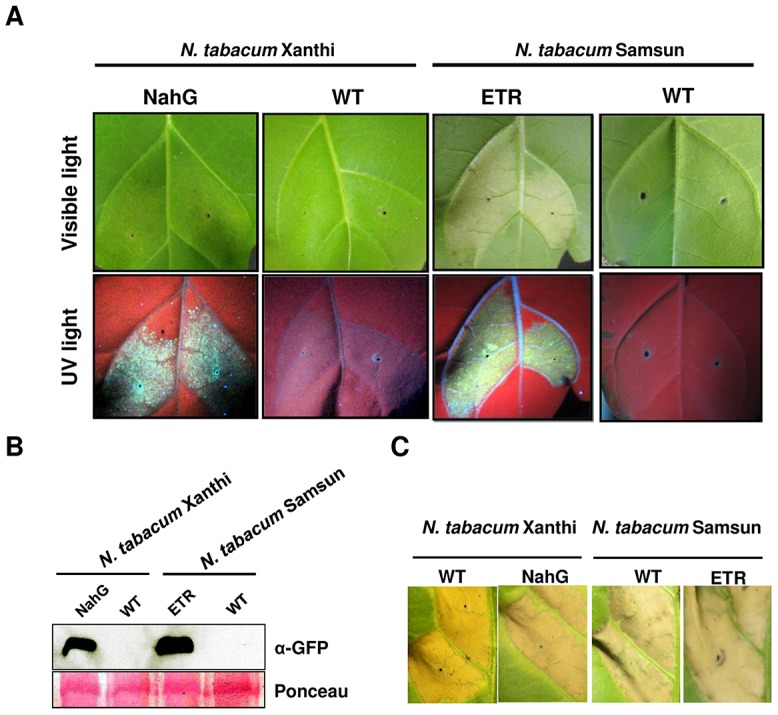
Salicylic acid and ethylene are required for extreme resistance induced by P19 against TBSV.(A) Leaves of SA-deficient and ethylene-insensitive plants, or their corresponding WT counterparts, were infiltrated with Agrobacterium tumefaciens expressing TBSV-GFP. Leaves were observed under optical light and GFP fluorescence was visualized under UV at 5 dpi. (B) Western analysis was conducted to detect TBSV-GFP accumulation in the infiltrated leaves depicted in (A), using an anti-GFP antibody. Ponceau staining of the membrane is shown to demonstrate equal protein loading. (C) A. tumefaciens expressing P19 triggers an HR response is all depicted genotypes at 5 dpi. Experiments were repeated three times and showed similar results.